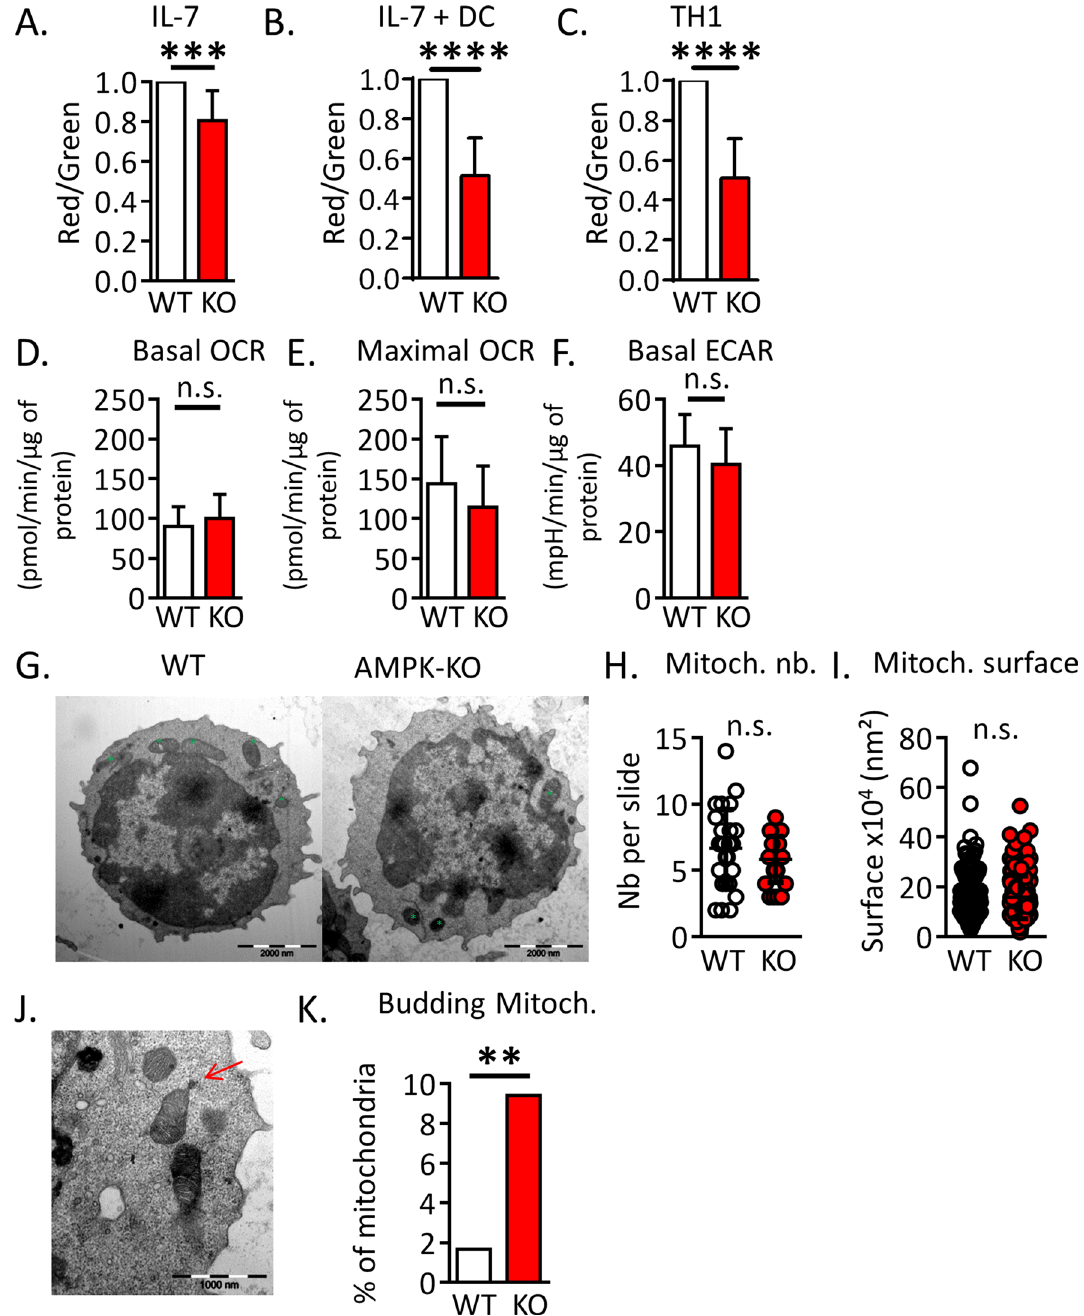
Figure 4. AMPK promotes mitochondrial fitness of T cells . ( A – C ) Mitochondrial membrane potential measured as a ratio of JC1 Red/Green fluorescence ratio in naive T cells ( A ), homeostatic proliferation- recovered T cells ( B ) and memory-like Th1 cells ( C ), with WT ratio set to 1. ( D – F ) Basal OCR ( D ), maximal OCR ( E ) and ECAR ( F ) of WT and AMPK-KO T cells recovered after 14 days of homeostatic proliferation. ( G – I ) TEM analysis of WT and AMPK-KO naive T cells. Representative images ( G ), numbers ( H ) and areas ( I ) of mitochondria (a total of 179 (WT) and 170 (KO) mitochondria from 27 (WT) and 29 (AMPK-KO) T cells analyzed are represented). ( J , K ) Image representative ( J ) and percentage (K) of mitochondria presenting a budding protrusion (WT : 3 out of 179, AMPK-KO : 16 out 170 mitochondria). Data are representative of 7 ( A , B ) or 2 ( H , I , K ) experiments or are pooled from 9 ( C ) or 2 ( D – F , n = 6) independent experiments. Statistical analysis: paired t-test ( A – C ), Mann–Whitney ( D – F , H – I ), Chi 2 ( K ). **p < 0.01; ***p < 0.001; ****p <